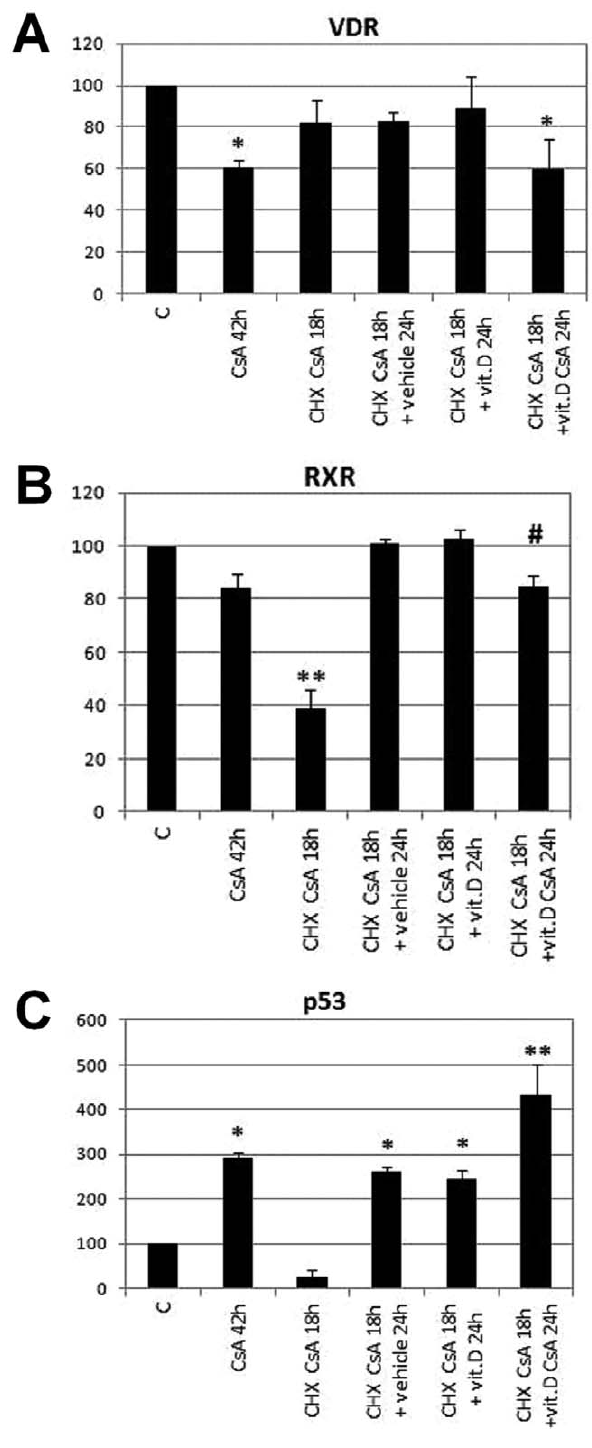
Figure 3. Analysis of mitochondrial translocation of VDR in presence of cyclosporin A. HaCaT cells were treated with cyclosporin A (CsA), cycloheximide (CHX) or 100 nM 1,25D3 (Vit.D) as indicated and 30 m g of mitochondrial proteins were analysed by western blotting for VDR, RXR a and p53 expression. Bands were quantified, normalized for loading as a ratio to VDAC expression and data plotted on graph as percentage of control. Data represent the mean 6 S.D of three independent experiments. * p , 0.05 and ** p , 0.001 compared to control. # p , 0.05 vs CHX CsA 18 h + vit.D 24 h.